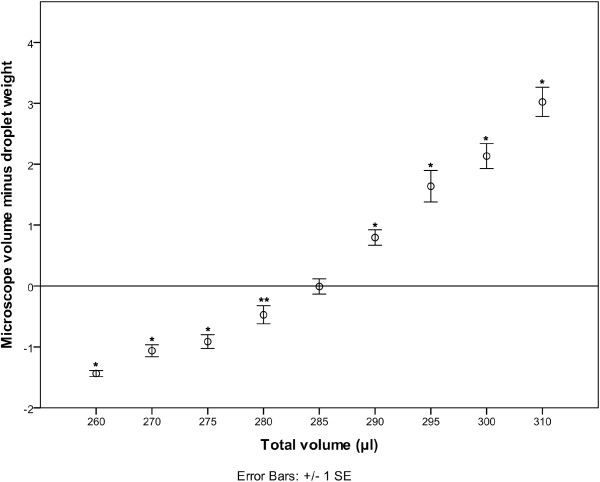
plot of the difference between the mean droplet volume measured optically (μl) and by weight (mg) for each total liquid volume (oil+MilliQ water) with significant differences indicated (*=p>0.001, **=p>0.01).